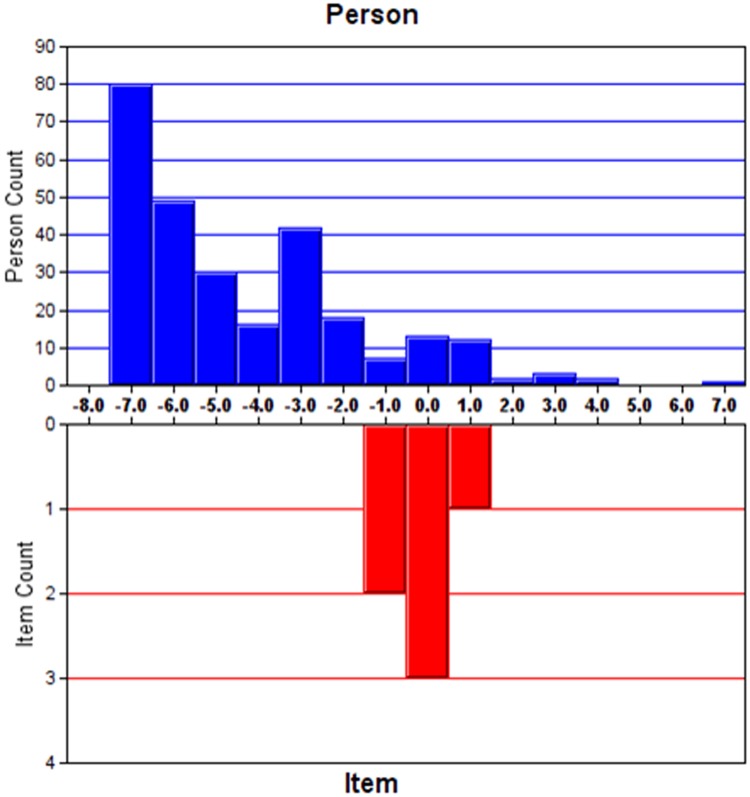
Person-item location distribution for HADS-Anxiety.